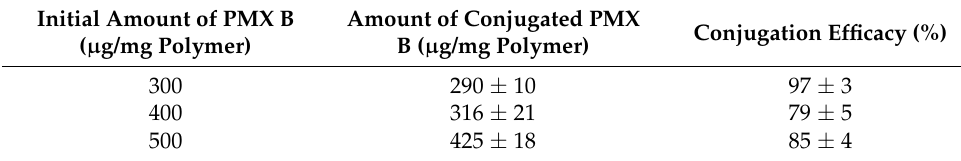
Table 4. Efficacy of PMX B conjugation with ox-PMAG depending on the initial amounts of antibiotic (the results are presented for conjugates with reduced aldimine bonds). Initial Amount of PMX B